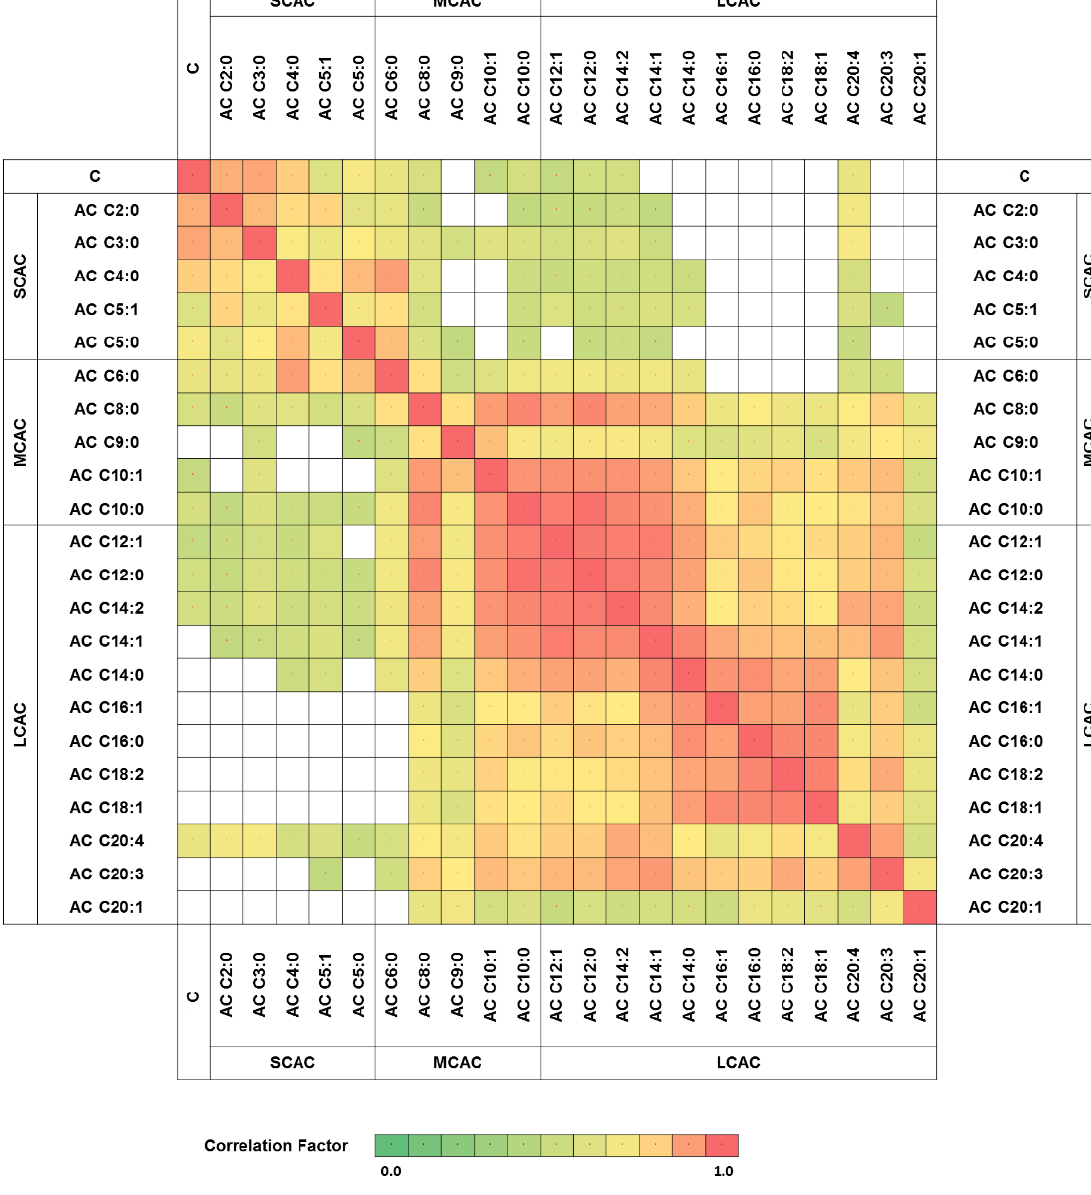
Figure 1. Carnitine and acylcarnitines correlation network. Only statistically significant correlation factors were presented ( p < 0.05). AC—acylcarnitine; C—carnitine; SCAC—short-chain-length acylcarnitines; MCAC—medium-chain-length acylcarnitines; LCAC—long-chain-length acylcarnitines.